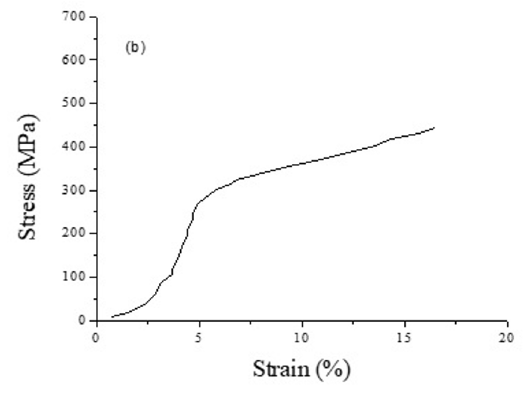
Figure 2. Stress-strain curve on uniaxial compression at room temperature. The presence of the B19' phase in the EQSC samples was revealed by X-ray diffraction (Fig. 3b). In the EBSD image (Fig. 1b), the residual B2 regions show a nonuniform coloration due to residual stresses from work